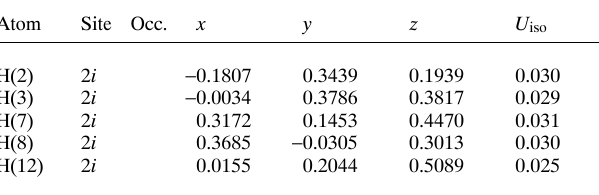
Table 8. A tomic coordin a tes a nd displ a cement p a r a meters (in Å 2 ) . A tom